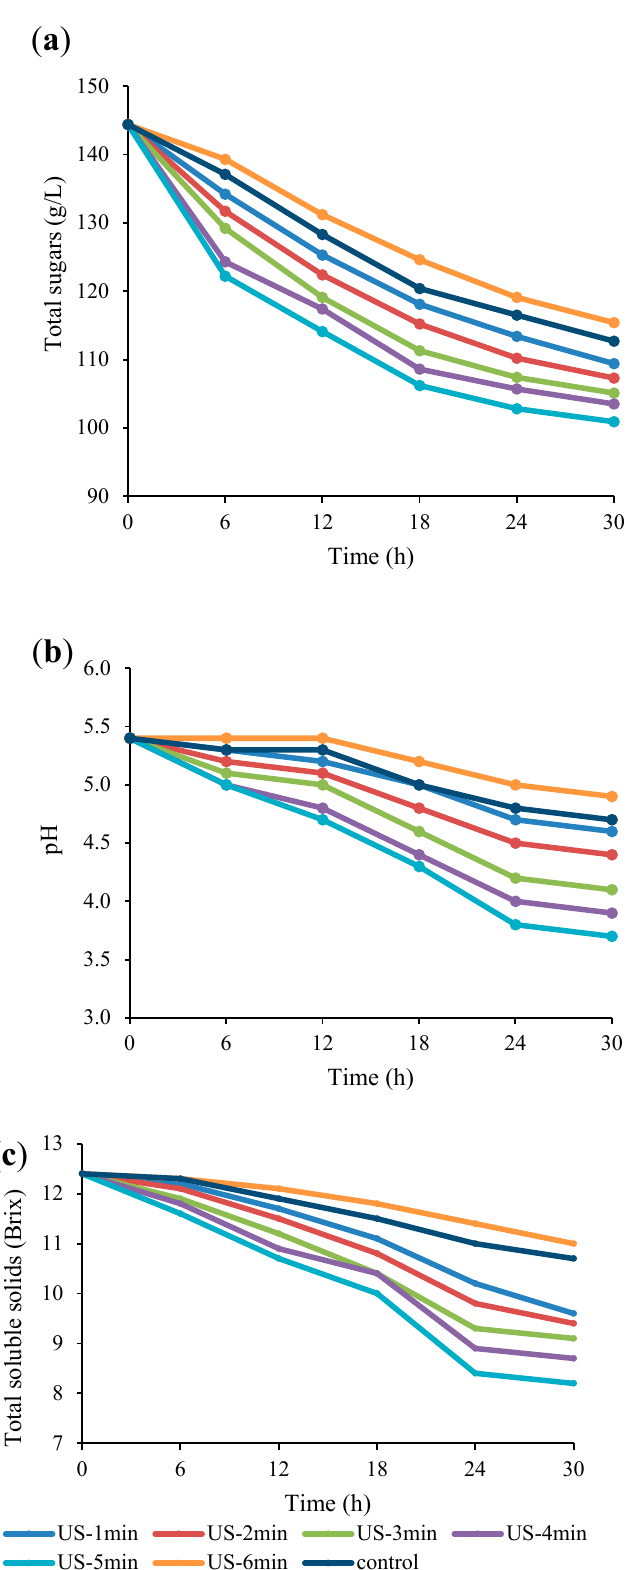
Figure 2. Variations in total sugars ( a ), pH ( b ), and total soluble solids ( c ) in US-treated and non-US treated Bakraei juice during fermentation. Error bars reveal the standard deviation of each measurement in Bakraei juice during 30 h of fermentation. US-1 min: ultrasound treatment for 1 min, Control: non-ultrasound treated juice.